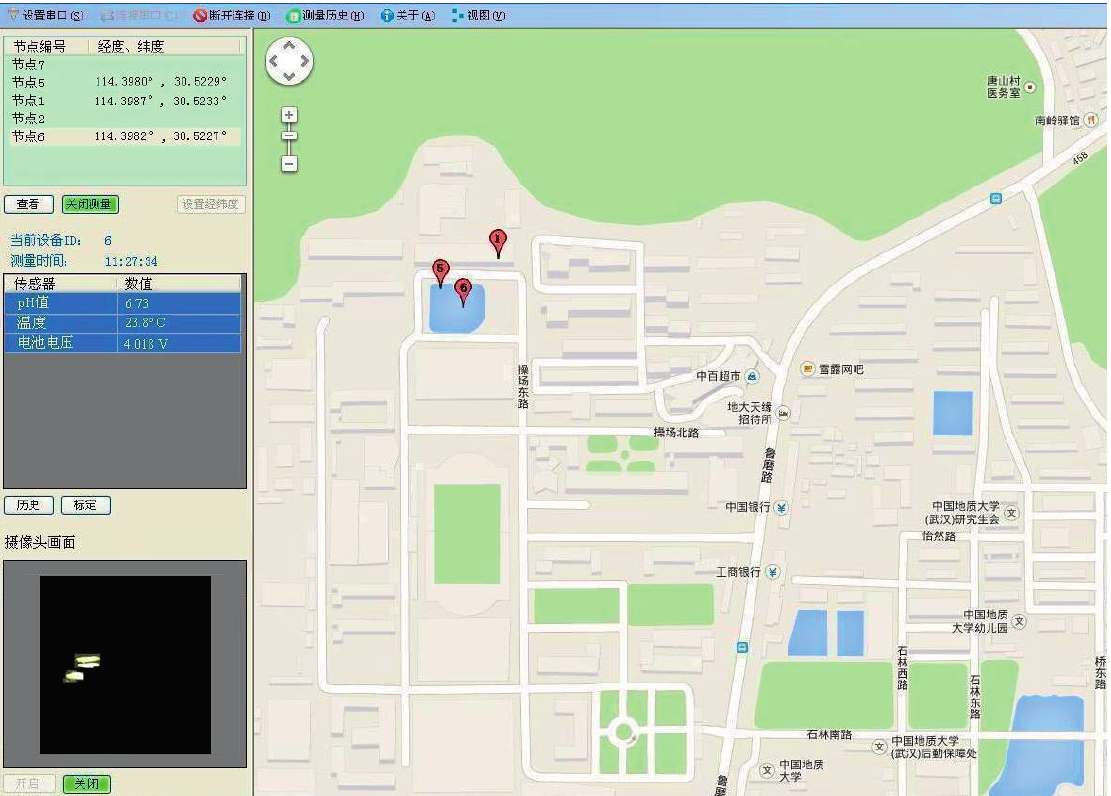
Figure 13. Debris detection (16 × 16 block size) using aquatic sensor nodes 5 and 6. ( a ) The images captured by two nodes; ( b ) The corresponding detection results; ( c ) The recovered images.